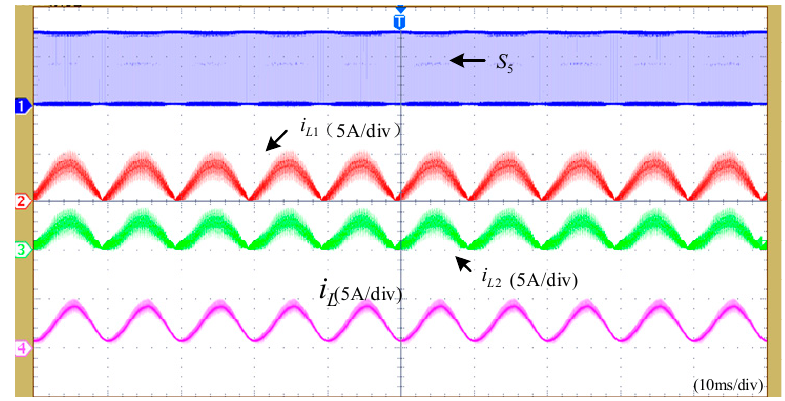
Figure 13. The experimental waveform of the inductor currents operating in the charging mode under a unity power factor ( P = 400 W, Q = 0 var, cos ϕ = 1 ).